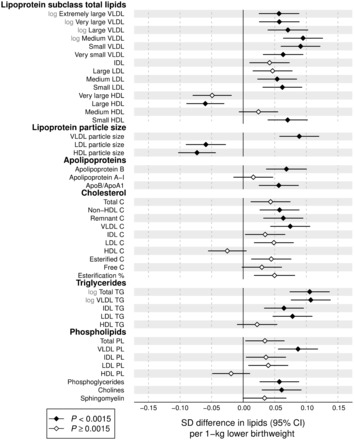
Birthweight associations with adult concentrations of lipoprotein lipids. The associations were adjusted for sex, gestational age and age at blood sampling, and meta-analysed for 18 288 individuals from seven cohorts. Association magnitudes are 1 SD lipid concentration per 1 kg lower birthweight. Error bars denote 95% confidence intervals. Filled diamonds indicate P < 0.0015. Association magnitudes in absolute concentration units and P-values are listed in Table S1, and results for individual cohorts are shown in Figure S5, both available at IJE online.